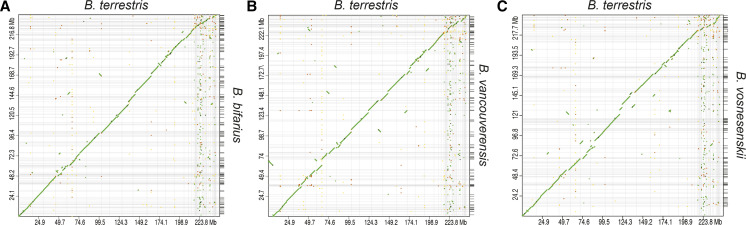
D-GENIES dot plots (using Minimap2 aligner) indicating collinearity of scaffolds (>100 kb in length) with the Bombus terrestris genome for A) Bombus bifarius, B) Bombus vancouverensis, and C) Bombus vosnesenskii.